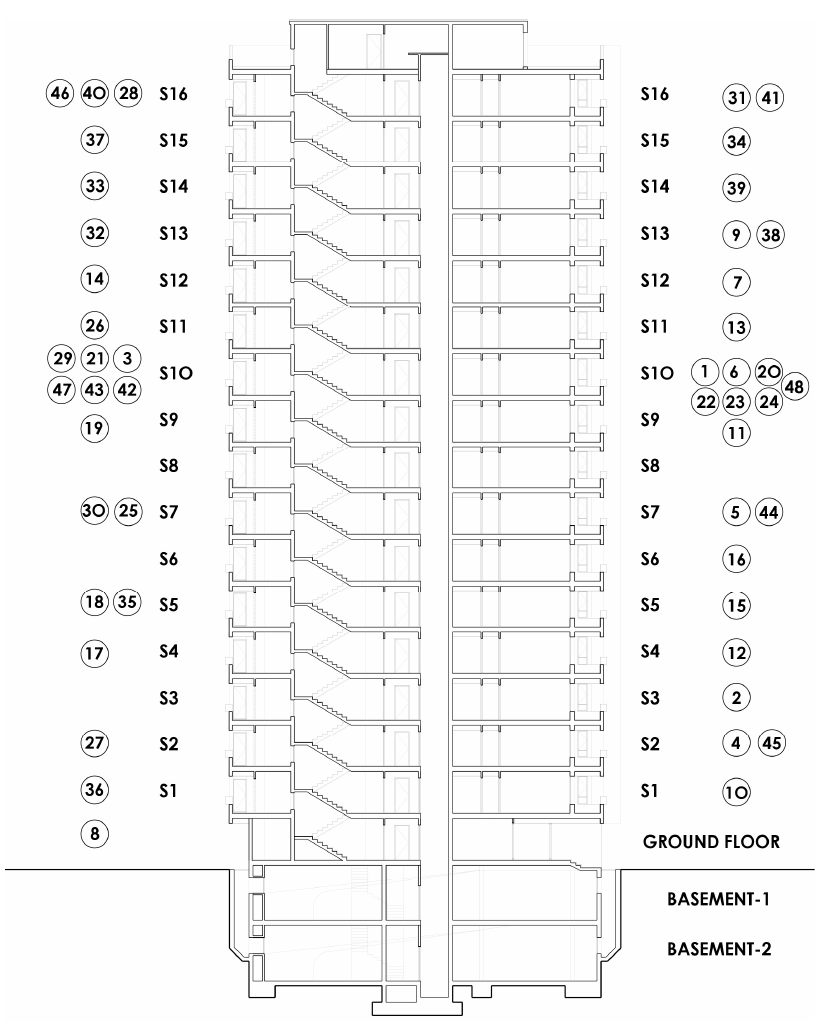
Figure 4 . Building’s section. Figure 4. Building’s